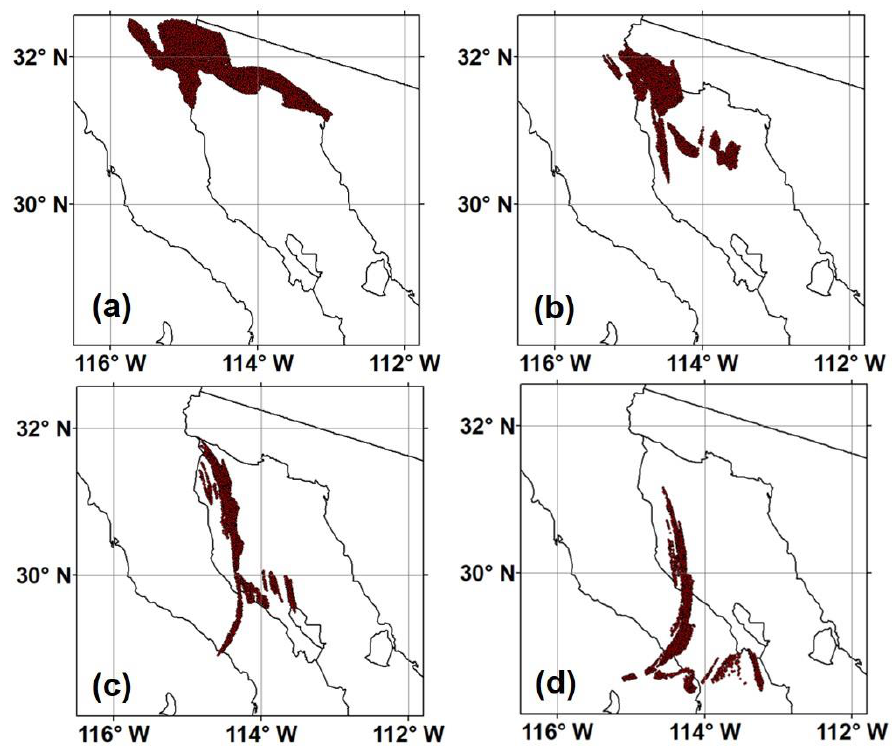
Figure 11. Particles positions from Altar Desert area at different time steps on October 22, (a) 12:00 UTC, (b) 14:00 UTC, (c) 16:00 UTC and (d) 18:00 UTC.